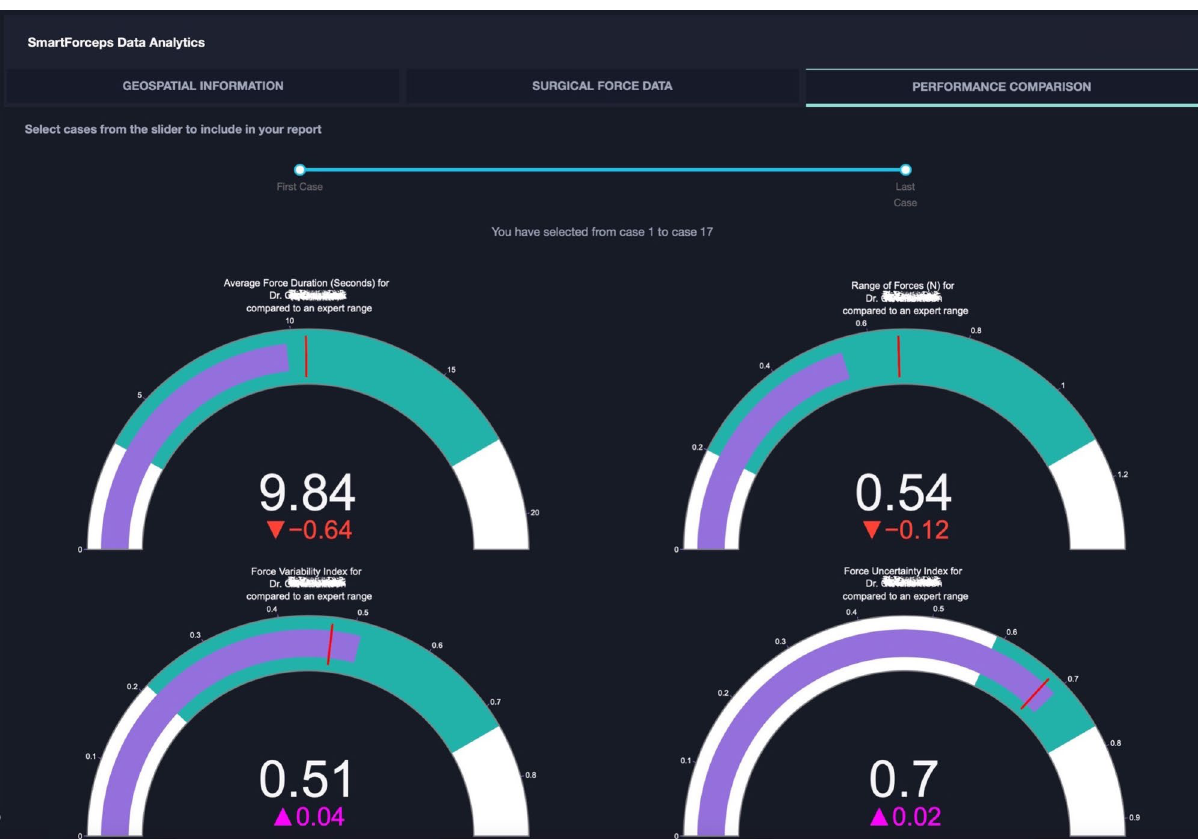
Figure 4. SmartForceps Data Analytics Dashboard in "Surgeon" view. The current view includes three tabs of "Geospatial Information", “Surgical Force Data”, and “Performance Comparison Dashboard”. These charts have fully interactive capability including zoom, pan, download, etc. This figure shows the overtime performance report (with the slide bar at the top to select range of cases) for a Novice surgeon with PGY > 4. The name is deidentified for privacy reasons. The gauge charts show the performance (purple bar) compared to the Expert surgeon (mean and standard deviation indicated as red mark and green area, respectively). In this graph, the representative surgeon gauge starts from zero as the baseline with the goal of reaching to the expert level values denoted by a red bar and green area. The figure for dashboard was created by Python Dash library version 0.43.0: https:// plotly. com/